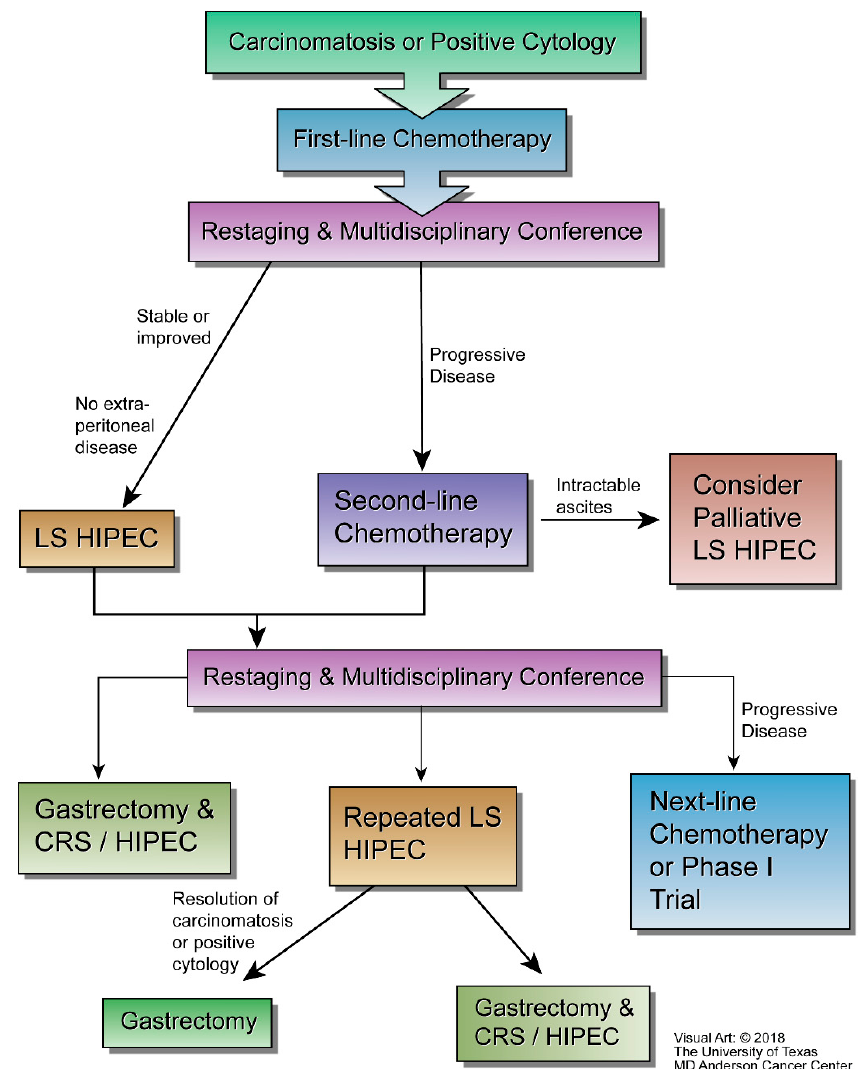
Figure 1. Flow chart of management of gastric cancer with carcinomatosis or positive cytology at MD Anderson Cancer Center.